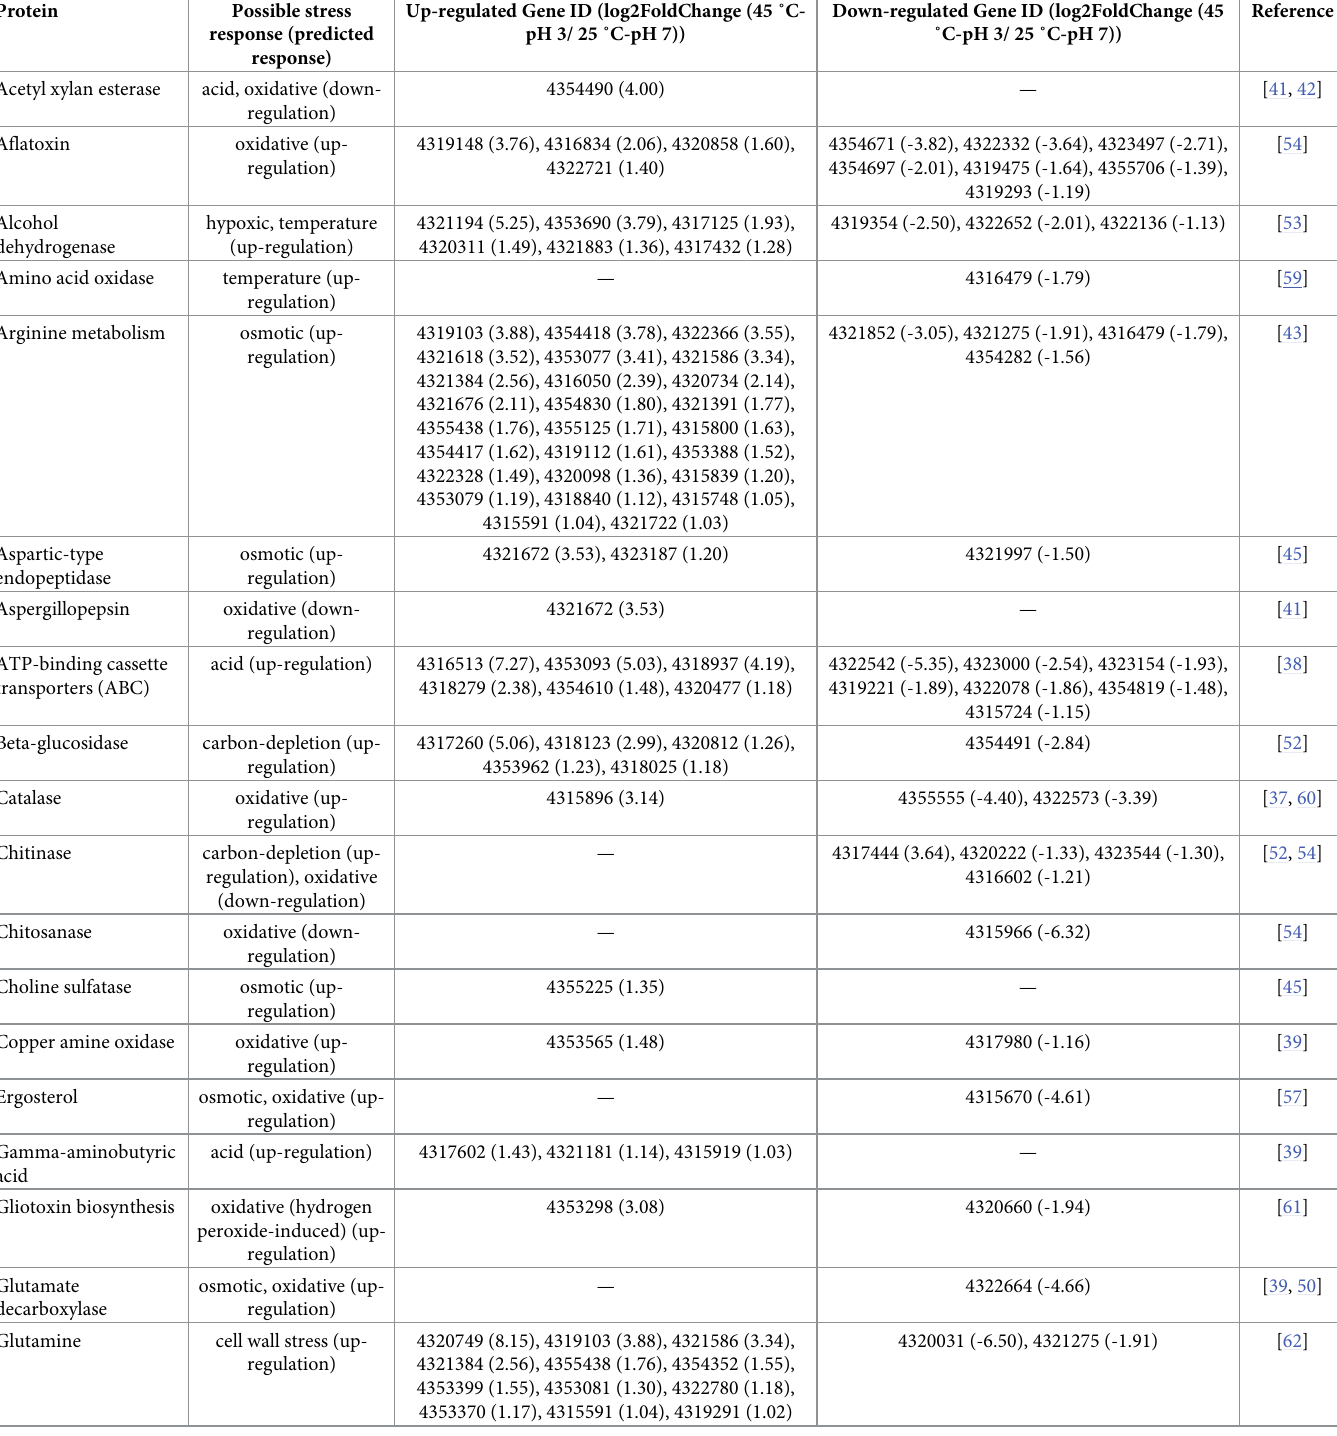
Table 1. Differential expressed genes in transcriptome of Aspergillus terreus NTOU4989 grown at 45 ˚C-pH 3 and 25 ˚C-pH 7 related to potential stress response of fungi. Proteins related to pH, oxidative, hypoxic, temperature, osmotic, carbon-depletion, cell wall and nitrosative stress responses in fungi.